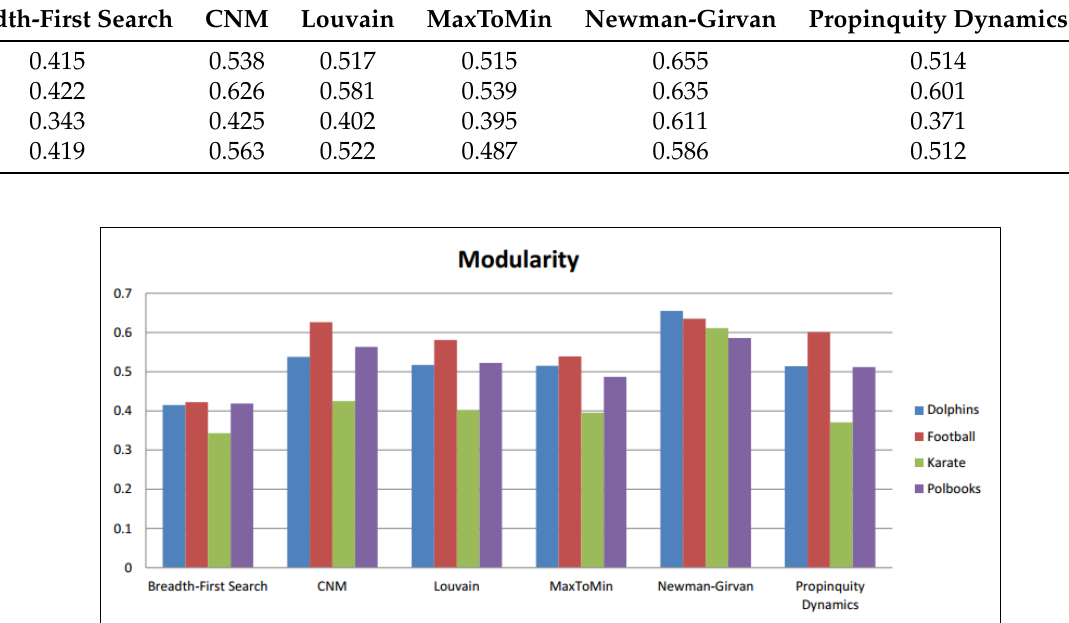
Figure 3. Graphical representation of